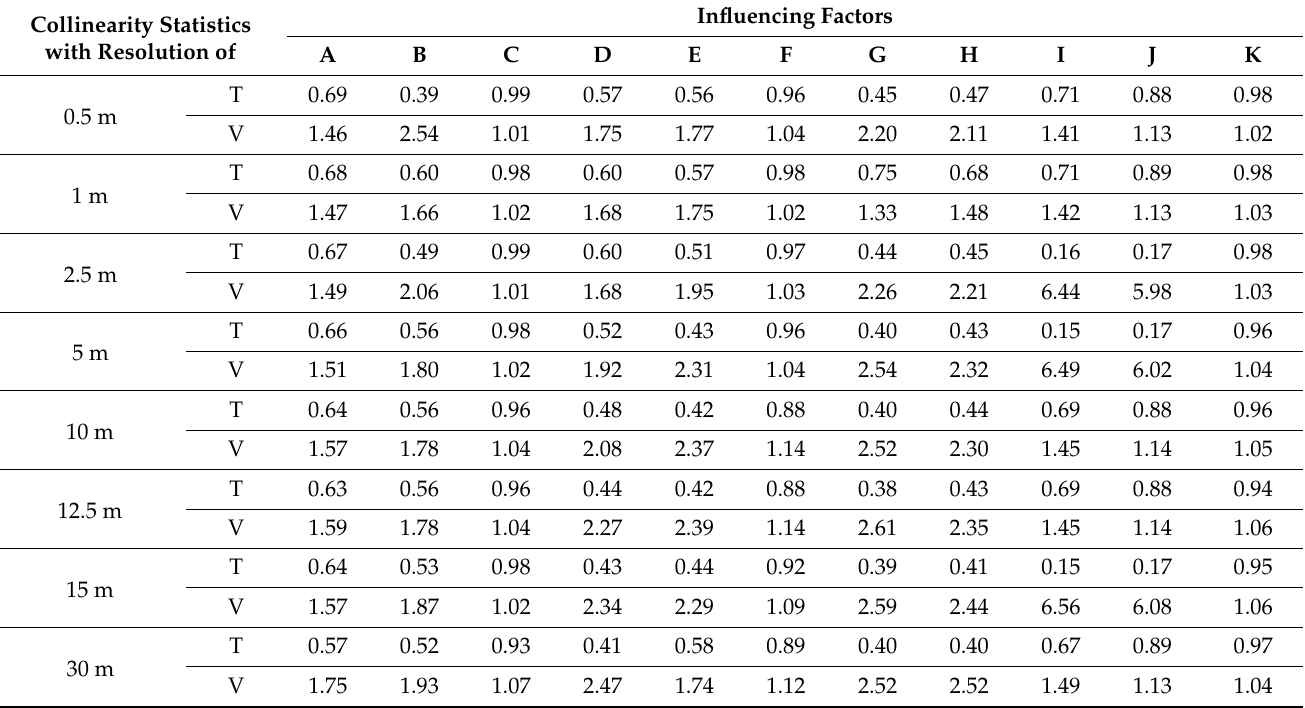
Table 1. Multicollinearity test among the factors that influence gully erosion at different